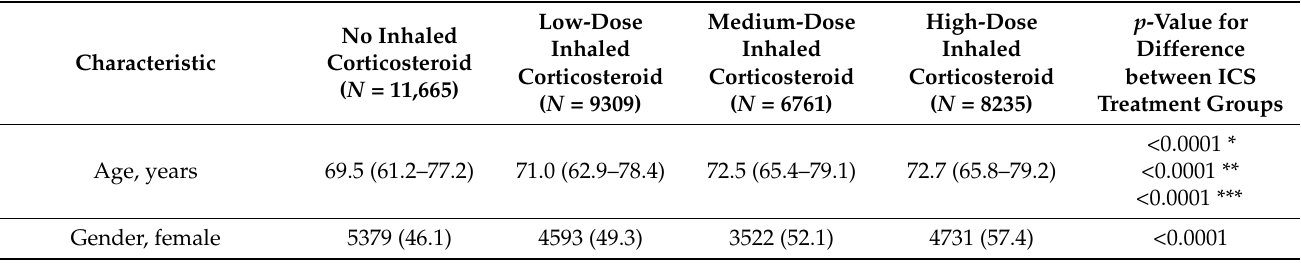
Table 3. Characteristics of ICS treatment groups of patients with COPD without asthma and without previous malignancy within 5 years prior to